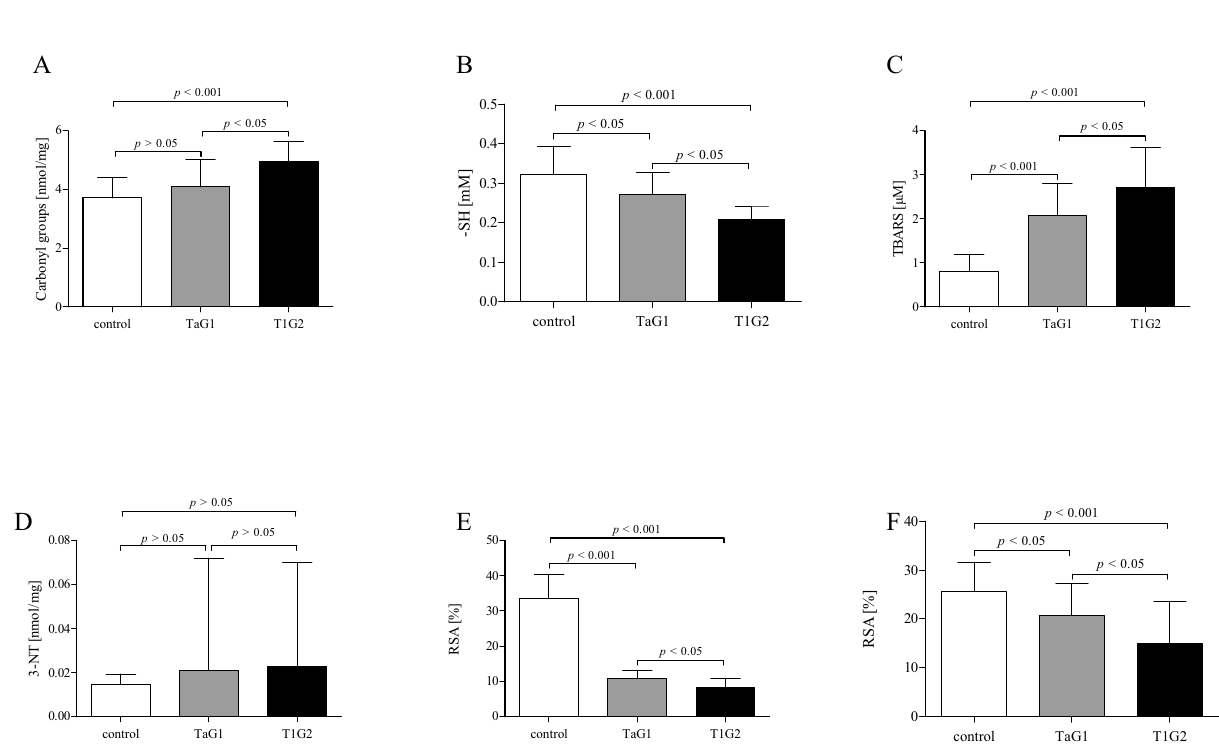
Figure 3. The level of carbonyl group ( A ), thiol groups ( B ), thiobarbituric acid reactive substances ( C ), 3-nitrotyrosine ( D ), the non-enzymatic antioxidant capacity determined by the reduction of DPPH · radicals ( E ) and ABTS · radicals ( F ) in blood plasma obtained from blood of TaG1 patients (n = 16), T1G2 patients (n = 14) and control group (n = 20). Statistical analysis was performed using one-way ANOVA analysis of variance with Tukey’s post-hoc